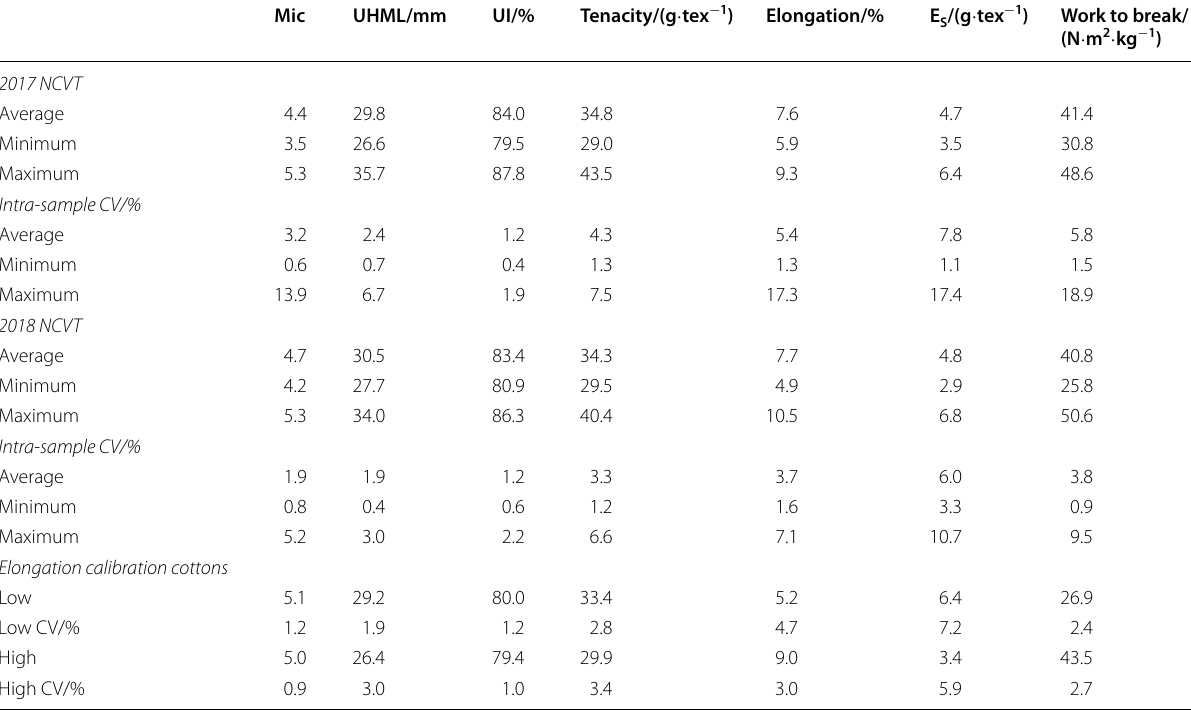
Table 3 Basic statistics of the HVI fiber properties for the samples Mic